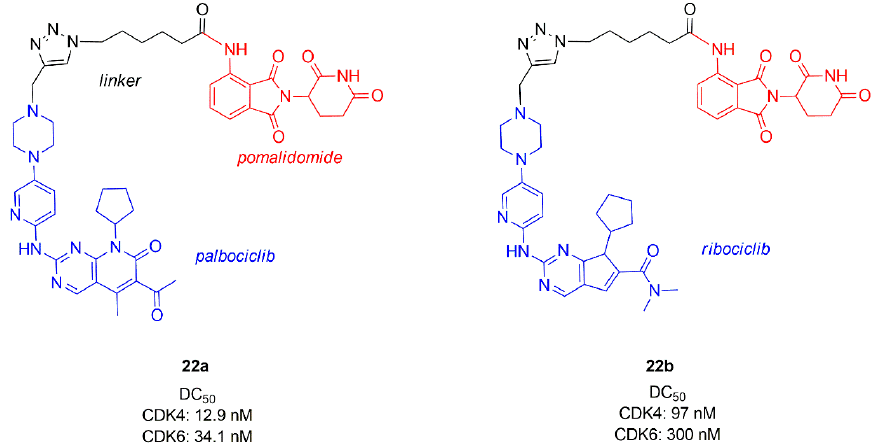
Figure 13. Chemical structures of palbociclib or ribociclib/pomalidomide PROTACs.